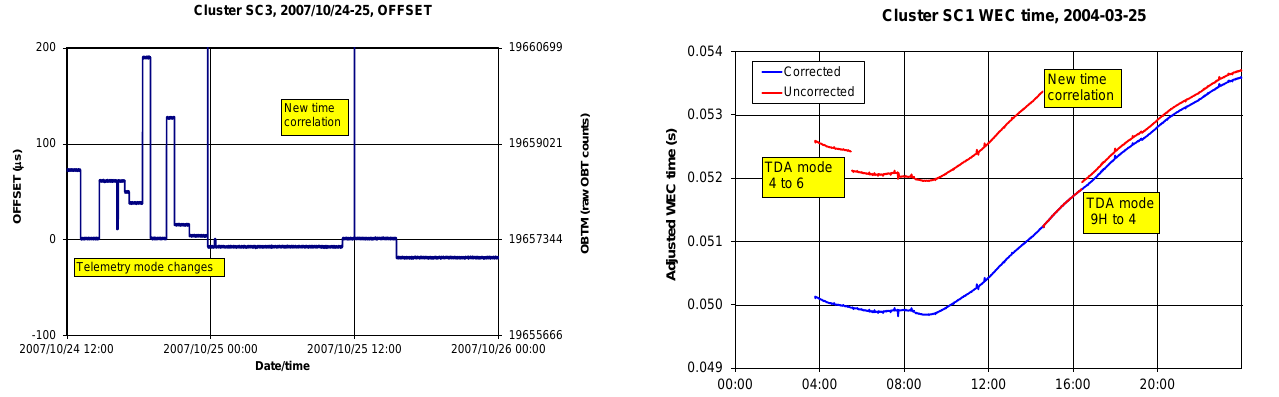
Fig. 4. OFFSET specifies the difference between the time of the ref- erence pulse (VC0 reset pulse) and the onboard time stamp recorded in the data packets. It applies only to data recorded on board, changes at every telemetry mode change, and is zero for real-time data. OFFSET normally ranges ± 180µs for normal mode data, and ± 30µs in burst modes. It is derived from analysis of the raw on- board time modulo 42207 × 2 11 (termed OBTM).